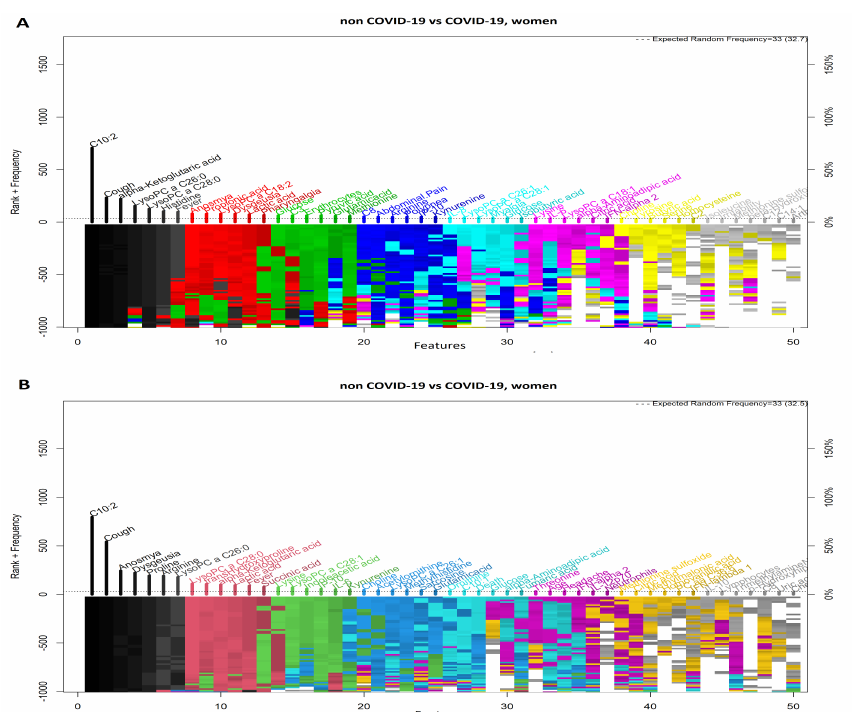
Figure 5. Feature–rank stability in 1000 models for the classification of women with or without COVID-19. ( A ) Logistic regression model and ( B ) Support Vector Machine model. The ”y positive” axis shows the number of times each feature was included in a given model (the frequency ranking). The ”y negative” axis shows the color coded rank of each feature as each model was generated. The ”x” axis shows the features ordered by rank. The starting color for each feature is assigned accordingly to the feature descending rank (from black down to